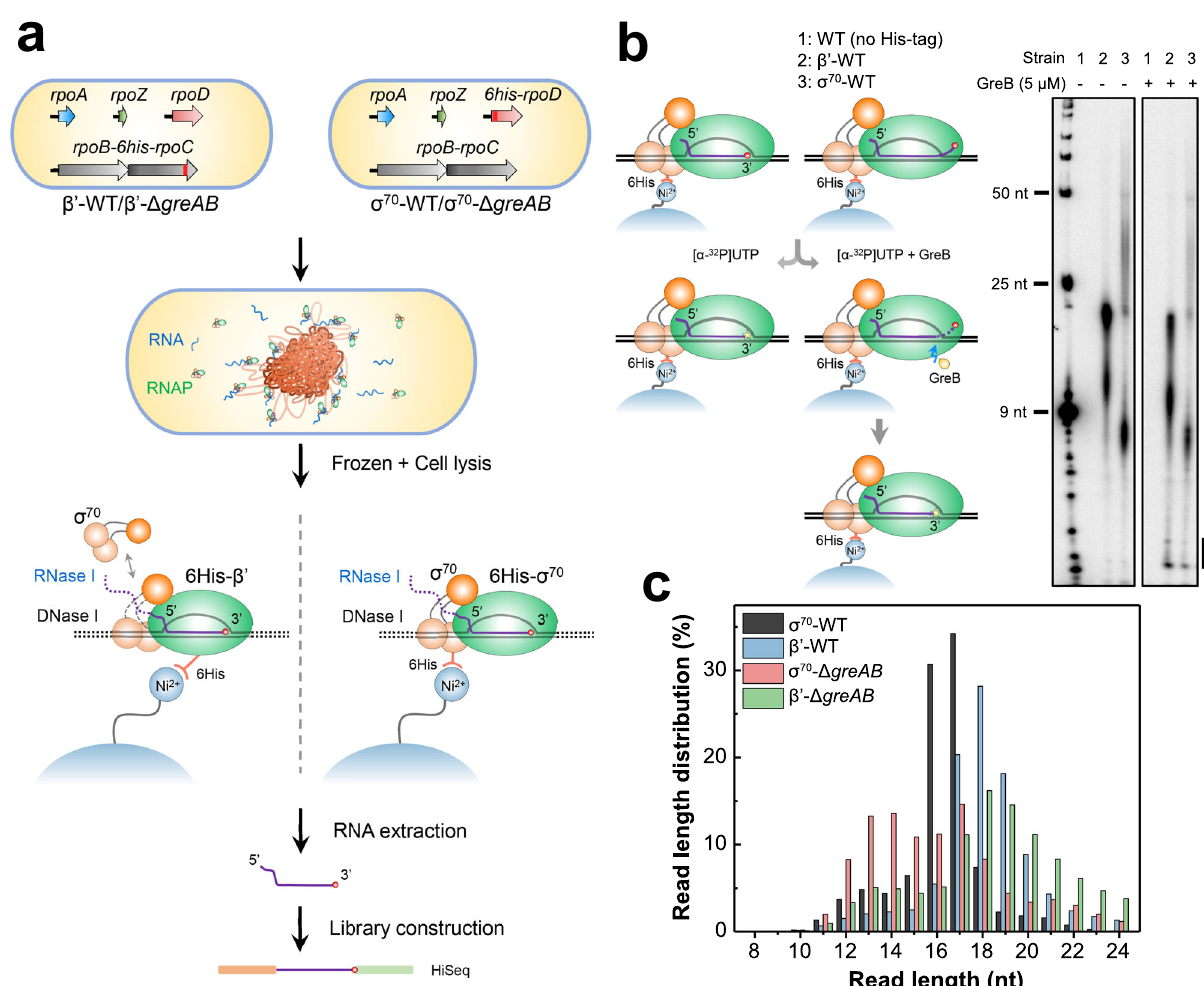
Fig. 1 RNET-seq identi fi es σ 70 -dependent pauses and the corresponding translocation states of RNAP in WT and Δ greAB cells. a Principles of RNET- seq. The σ 70 and β ’ strains with 6His-tagged RpoD ( σ 70 ) and RpoC ( β ’ ) subunits were used for puri fi cation of the intact paused TECs from bacterial nucleoids after treatment with nucleases (see details in Methods). The green oval represents the RNAP core enzyme. Three connected brown circles represent individual domains of the σ 70 subunit bound to the − 10/ − 35 promoter elements or to RNAP core. β ’ -WT/ β ’ - Δ greAB , WT or Δ greAB with His- tagged β ’ ; σ 70 -WT/ σ 70 - Δ greAB , WT or Δ greAB with His-tagged σ 70 . b PAGE of the 32 P-RNA-labeled paused complexes and their sensitivity to GreB- stimulated cleavage. WT, E. coli W3110 strain lacking the His-tag in σ 70 and β ’ . The fi rst lane, RNA ladder. Vertical bar, cleavage products. Similar quantity of paused TECs were used to allow direct comparison of the RNA yields between β ’ -WT and σ 70 -WT cells. Data shown are representative of three independent experiments. c Histogram shows RNA length distributions (RNA footprints) for the uniquely mapped RNET-seq reads from the indicated strains. The length of protected RNA allowed determination of the translocation register of RNAP in β ’ -WT at each pause: 16 − 17-nt, 18-nt and >18-nt RNAs corresponded to the post-translocated, pre-translocated and backtracked states, respectively 51 . The average read lengths for σ 70 -WT, β ’ -WT, σ 70 - Δ greAB and β ’ - Δ greAB strains are 16.3-nt, 18.0-nt, 16.0-nt and 18.3-nt. The <16-nt RNAs were derived from RNAP pausing at a short <16-bp distance from promoters where the nascent transcripts were not yet accessible to the